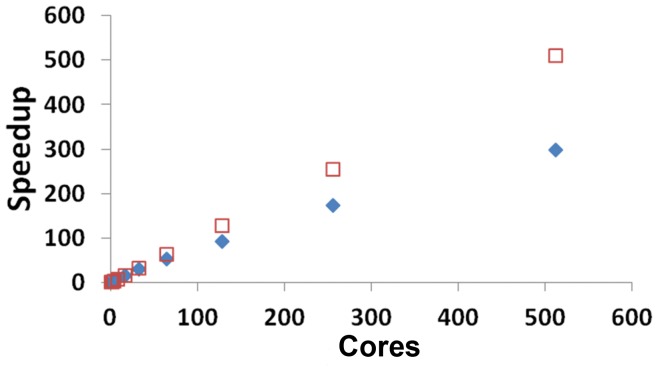
Parallelization Performance.Red squares are ideal speedup. Blue diamonds are the values measured using the gA48 sequence with no constraints on the Sooner supercomputer. Speed up is the ratio of real computation time in serial to real computation time in parallel. Note that one unit of work is assigned to each core, thus one node is equivalent to one core in this case.